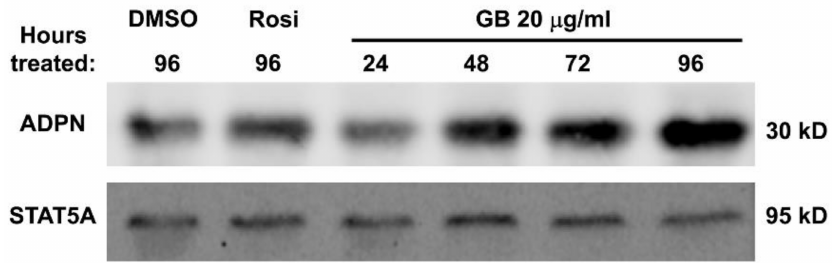
Figure 4. Groundsel bush increases adiponectin expression in mouse adipocytes. Fully differentiated 3T3-L1 adipocytes were treated with vehicle or 1 µ M rosiglitazone (Rosi) for 96 h, or with 20 µ g/mL groundsel bush extract for the indicated times. Each lane contains 50 µ g protein from whole-cell extracts pooled from two biological replicates. Extracts were separated by SDS-PAGE, transferred to nitrocellulose, and subjected to Western blot analysis. Membrane was probed for STAT5A as a loading control. Several independent experiments on different batches of 3T3-L1 adipocytes have shown that GB increases adiponectin expression in a time-dependent manner.